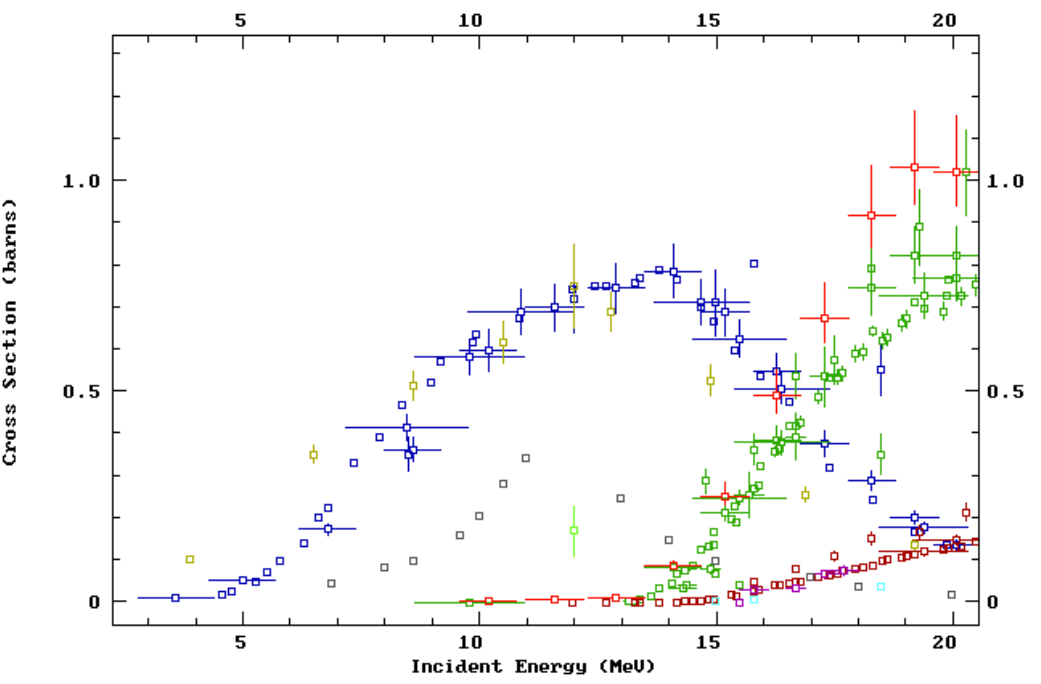
Figure S1. Screen shots of cross-section data plots accessed via NNDC/BNL for reactions that can be induced in nat Y by low-energy protons. ( p , n ) 89g Zr: blue, dark gray [29–36]; ( p , n ) 89m Zr: dark yellow, light gray [36,53]; ( p ,2 n ) 88 Zr: green [29,54–61]; ( p , n + p ) 88 Y: red, light blue, maroon, violet [29–32,35,55–61]. Some data sets included the contribution from isomeric transition, and some did